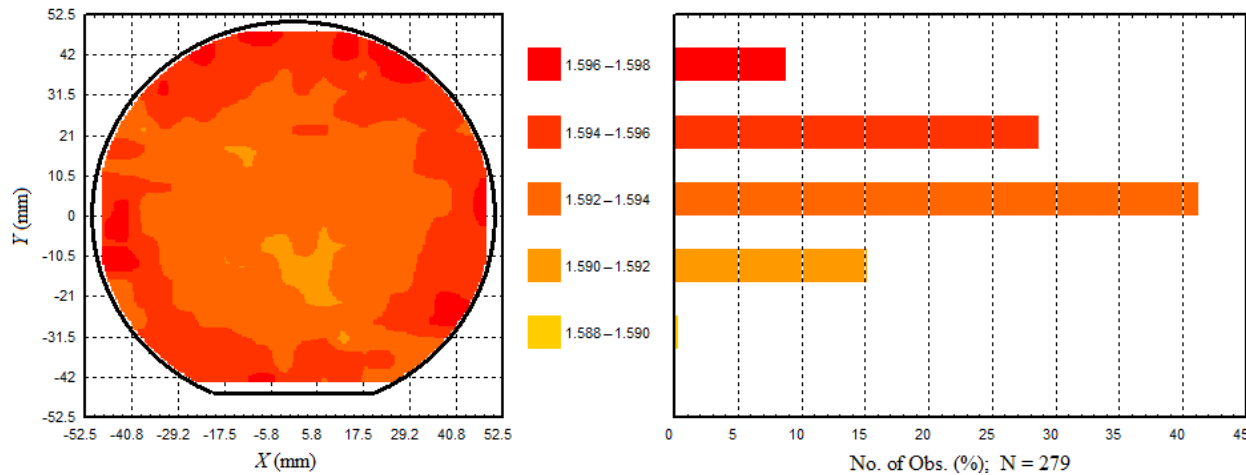
Figure 8. Distribution of refractive index of a thick SiON film across a 100 mm wafer obtained by micro-spot spectroscopic reflectometry.